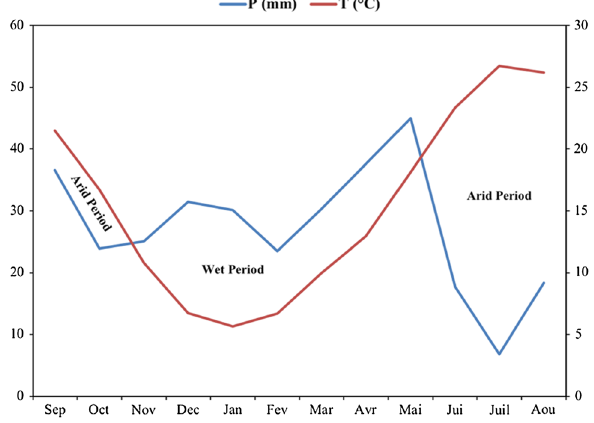
Fig. 4 Ombrothermal diagram of Bagnouls and Gaussen for Batna station